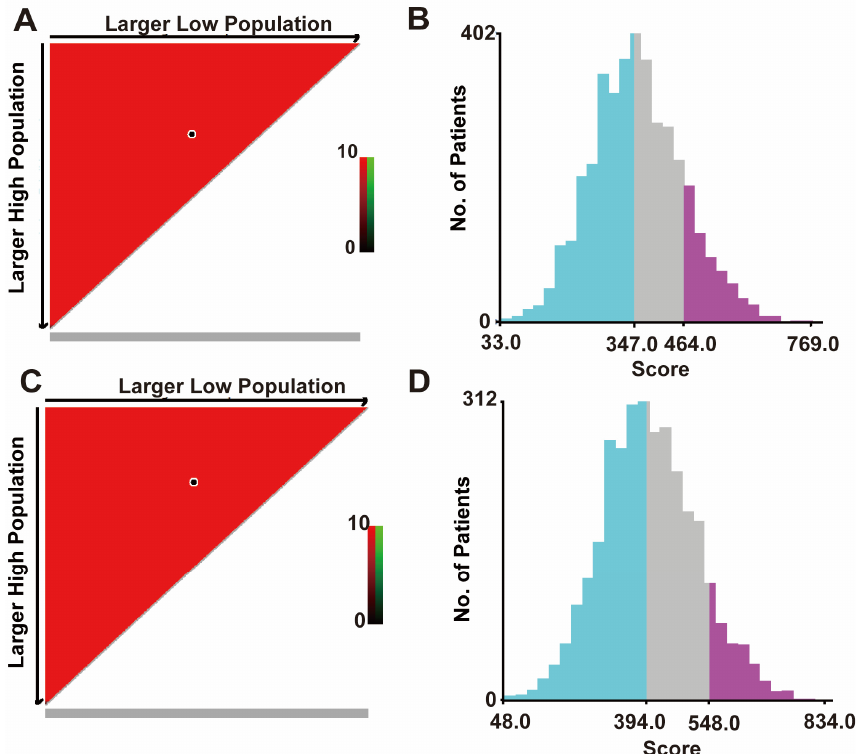
Figure 4. The cut-off values were calculated using X-tile based on the total scores. ( A ) The black dot in the figure indicates the OS distinction point selected by X-tile software. ( B ) The cut-off values of OS are 347 and 464. The blue color is the low-risk group, the gray color is the medium-risk group, and the purple color is the high-risk group. ( C ) The black dots in the figure represent the CSS distinguishing points selected by X-tile software. ( D ) The cut-off values of CSS are 394 and 548. OS, overall survival; the blue color is the low-risk group, the gray color is the medium-risk group, and the purple color is the high-risk group. CSS, cancer-specific survival. All patients under our group price adjustment are under the OS, CSS